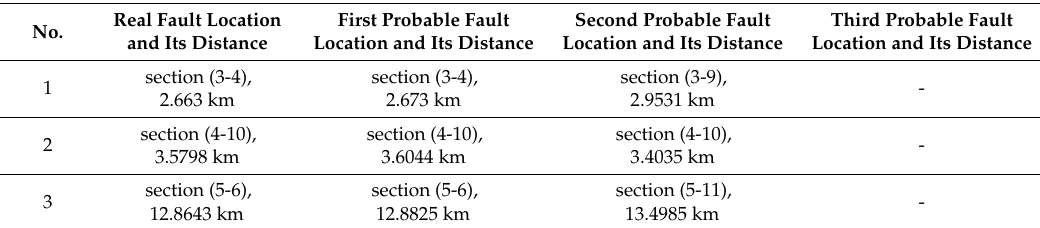
Table 3. Possible fault location at fault resistance of 150 ohms and different fault distances.